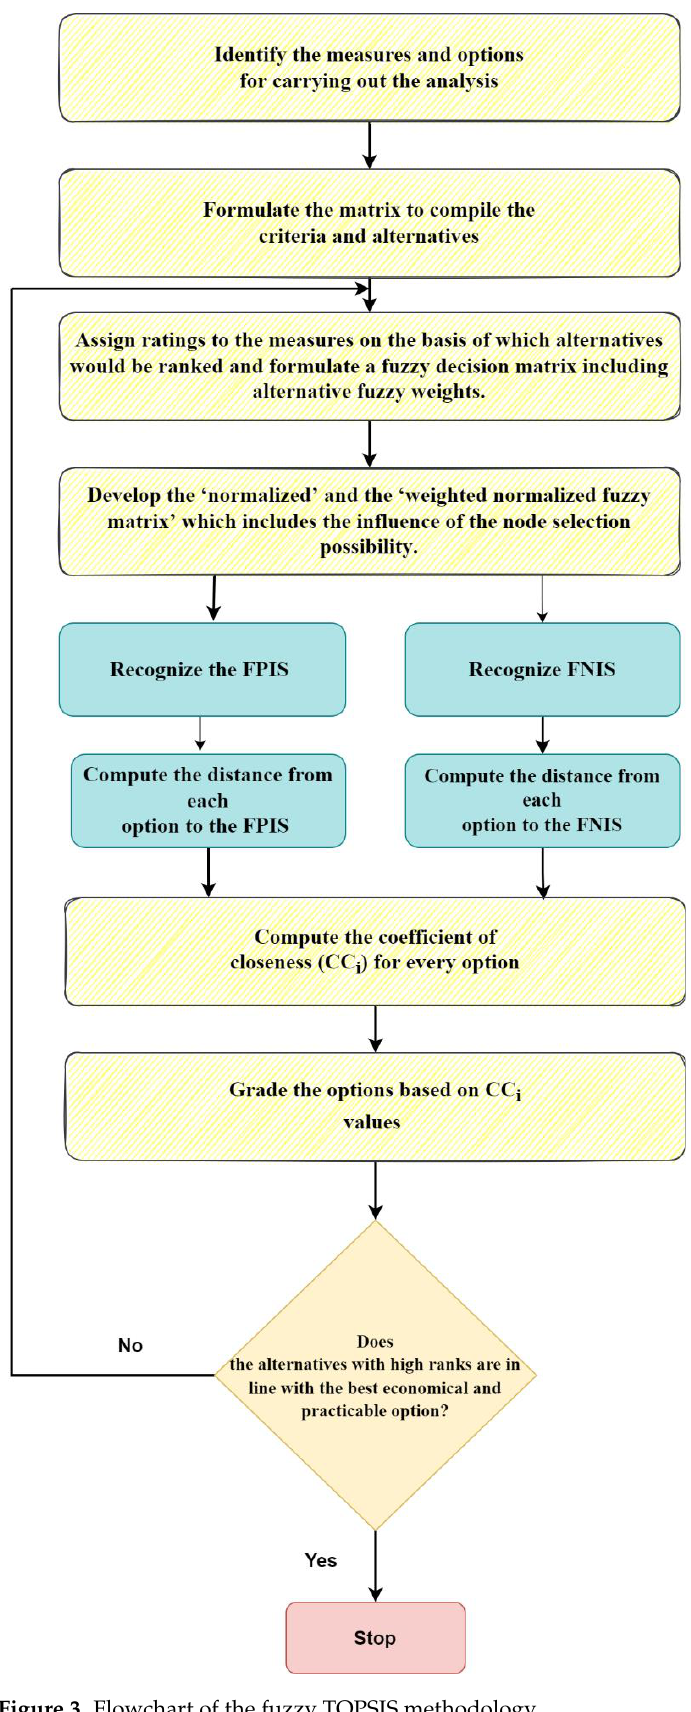
Figure 3. Flowchart of the fuzzy TOPSIS methodology.